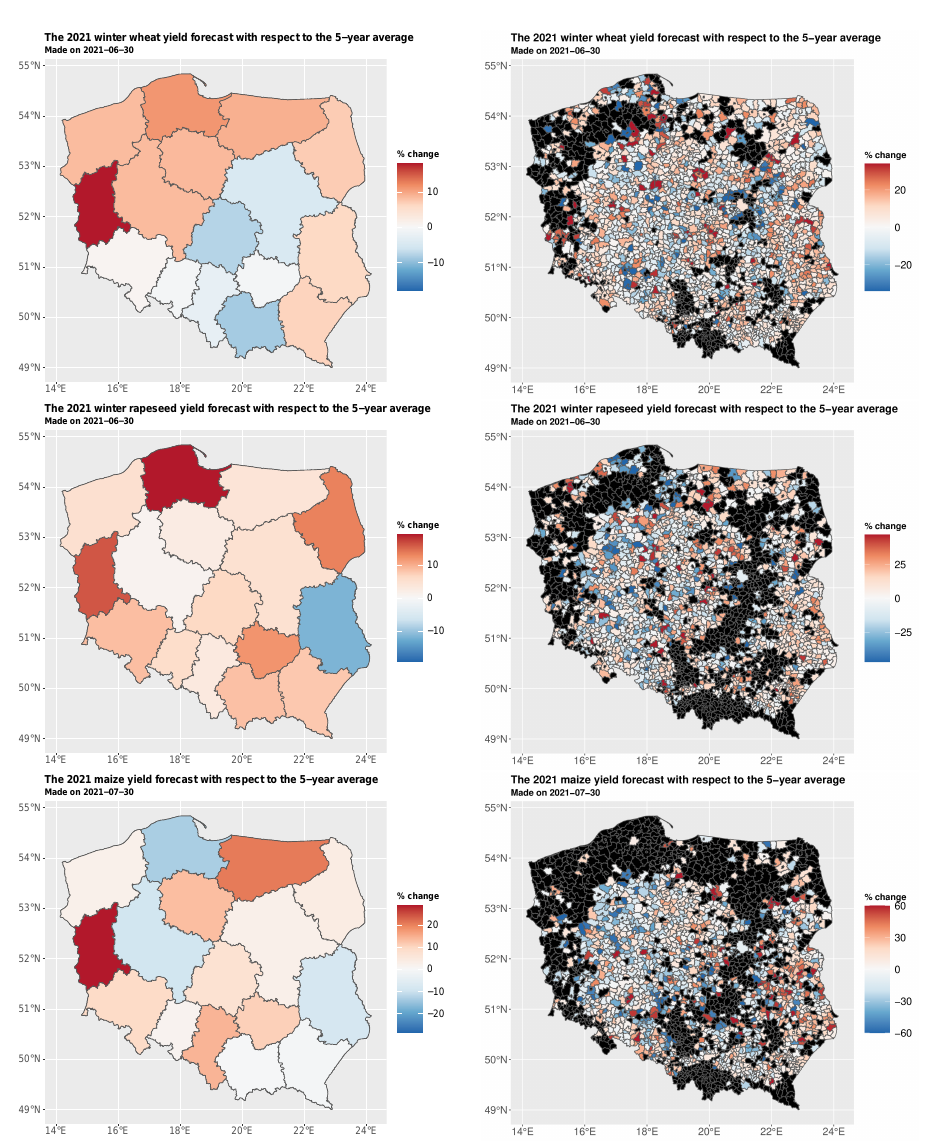
Figure 17. An example of the graphical output generated by the crop yield forecasting system: crop yield forecasts for winter wheat ( upper row ), winter rapeseed ( middle row ), and maize ( bottom row ) for NUTS-2 ( left column ) and LAU ( right column